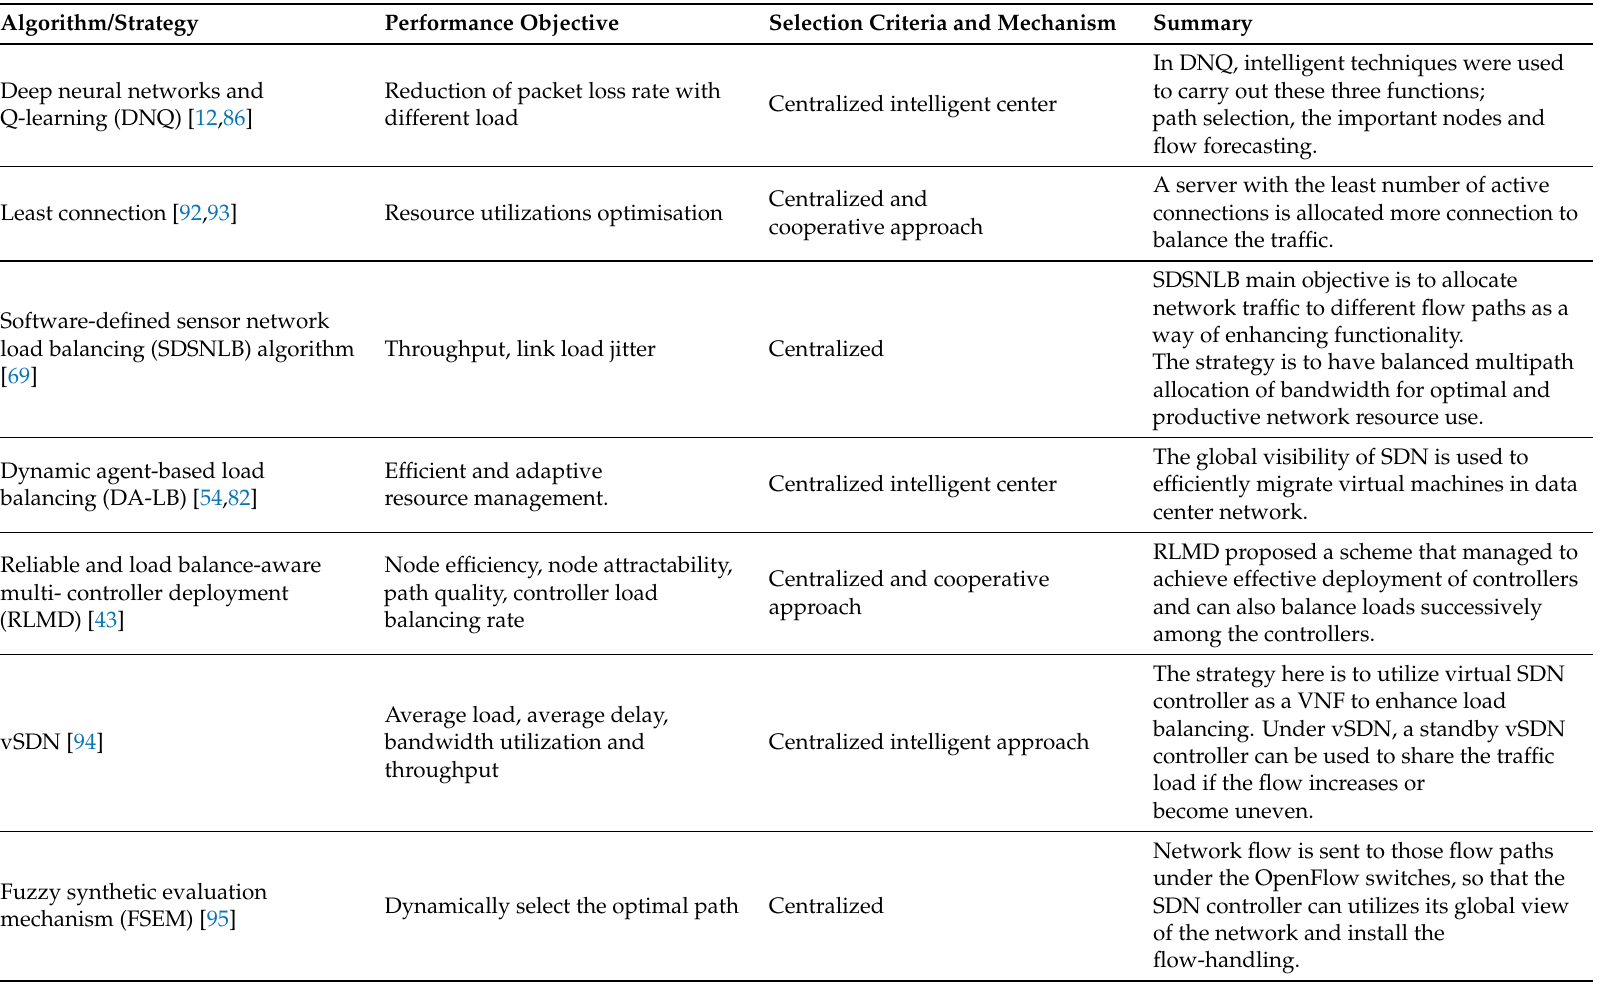
Table 1. A summary of various intelligent load balancing techniques in the software defined networking